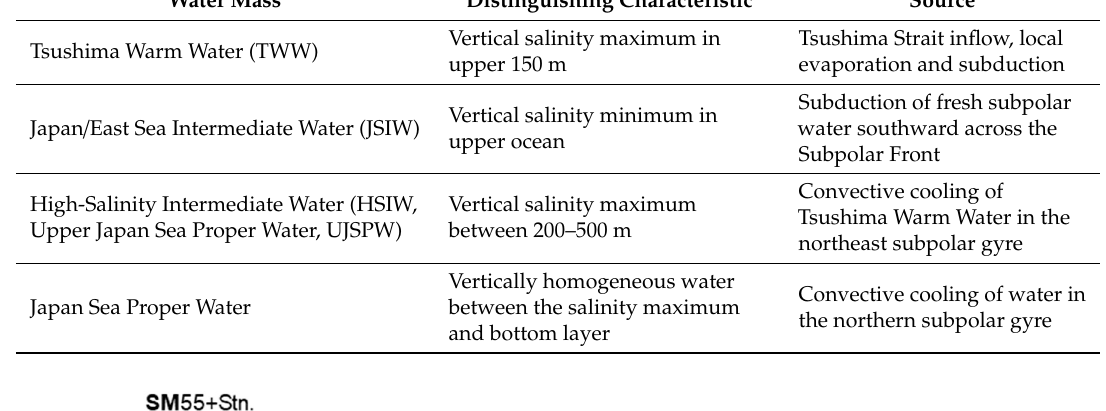
Table 1. Water Masses and Structures, Identifying Characteristics, and Source.